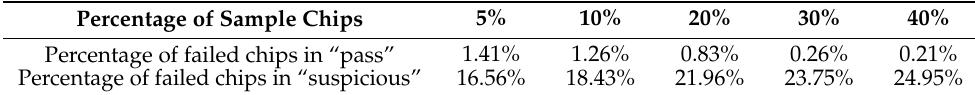
Table 1. Performance of quality prediction.